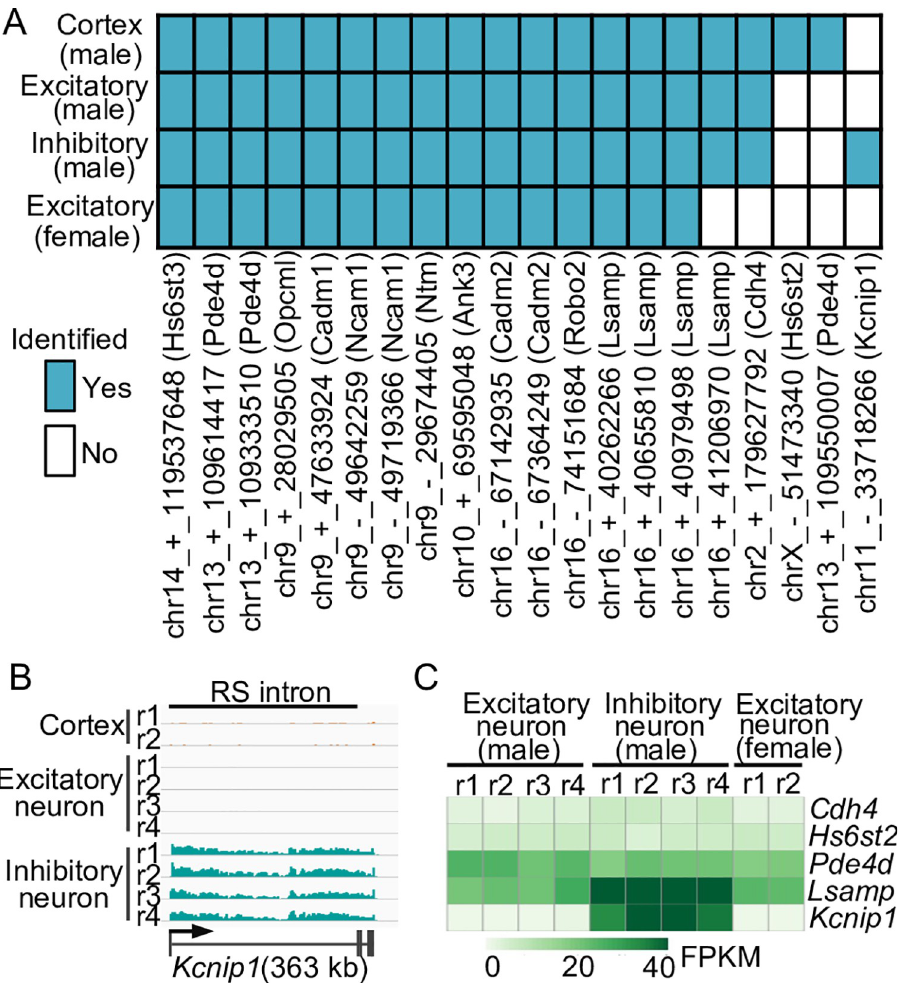
(male) at Kcnip1 locus. (C) Heatmap of expression levels of five genes in three cell types. FPKM, fragment per million uniquely mapped reads per kilobase of exonic